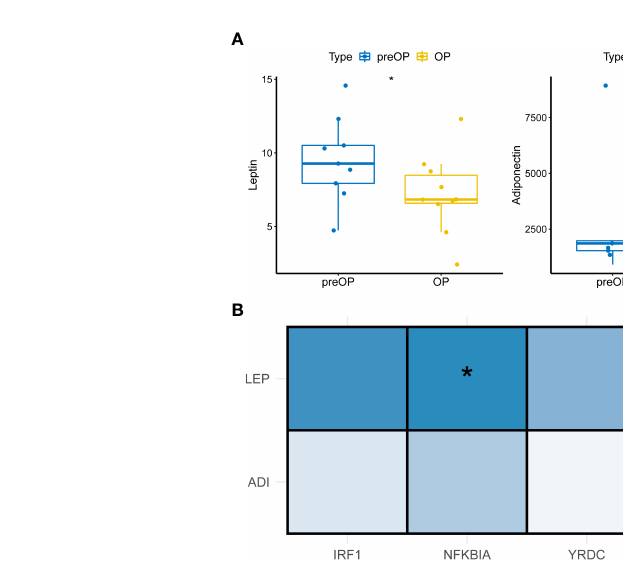
FIGURE 6 Pearson correlations analysis. (A) Box plot of Leptin and Adiponectin expression in patients before and after LSG treatment pre- and post-operation (Wilcoxon rank-sum test). *, p < 0.05. (B) Pearson correlation analysis of key characteristic genes with leptin and Adiponectin (cor = -0.48, P =